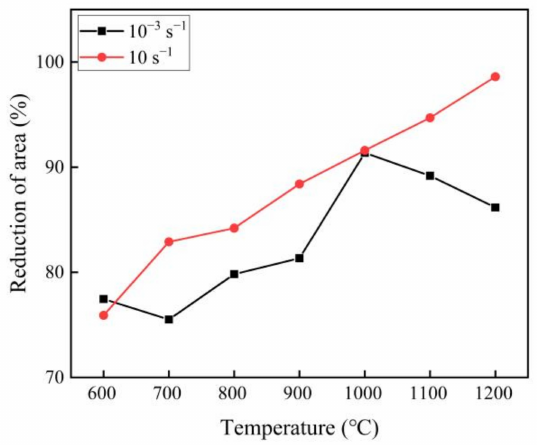
Figure 3. The curves of area reduction versus temperature of VL steel at different strain